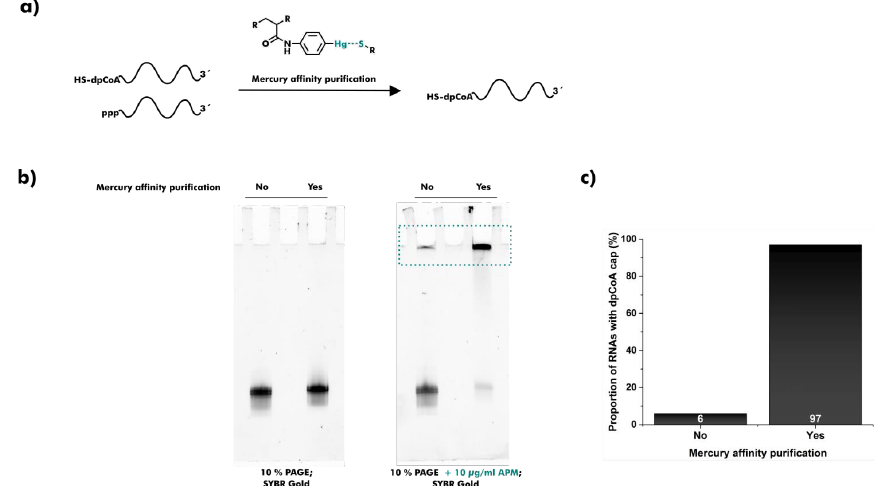
Figure 1. Mercury affinity purification of dpCoA-RNA. ( a ) Schematic overview of the purification principle. dpCoA-RNA is retarded by the interaction between its thiol and mercury (II) of co- polymerized 4-(acrylamido)phenylmercuric chloride (APM) during gel electrophoresis. ( b ) In vitro transcribed dpCoA-RNA was purified using 10% PAGE or a combination of 10% PAGE and 10% APM-PAGE. Both purification steps were analyzed using 10% PAGE (left gel) or 10% APM-PAGE (right gel) and SYBR Gold staining. The retarded dpCoA-RNA fraction is highlighted with a cyan frame. ( c ) Proportion of dpCoA-RNA before and after mercury affinity